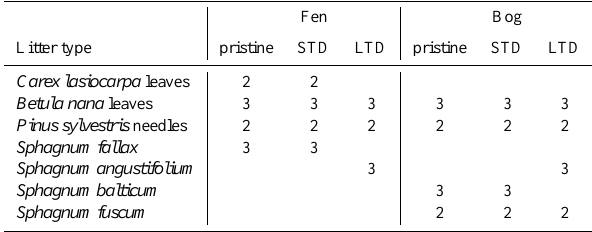
Plots: pristine, undrained; STD, short-term water table drawdown; LTD, long-term water table